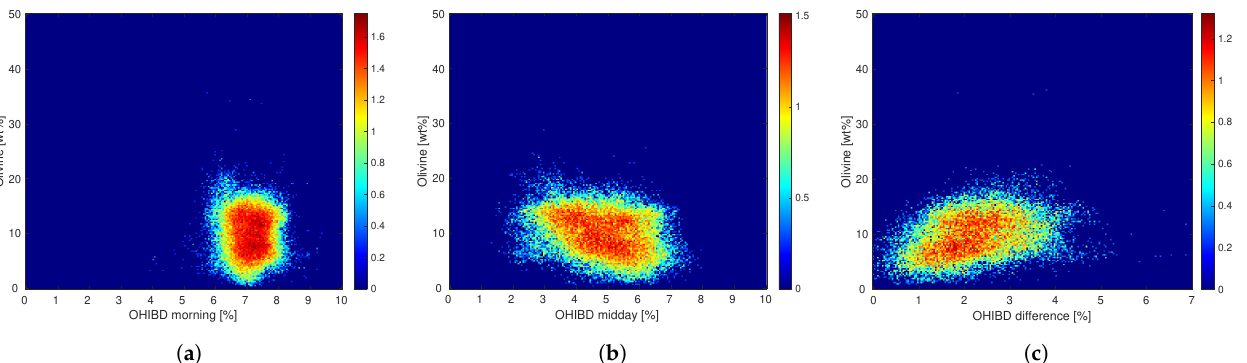
Figure A6. Density plots for the olivine weight percentage from Lemelin et al. [58] plotted against the OHIBD values at different times of day. The comparison is limited to the equatorial mare regions on the lunar near-side because the abundance of olivine in the highlands is negligible. The color bar represents the decadal logarithm of the number of examples at a discrete pixel in parameter space.